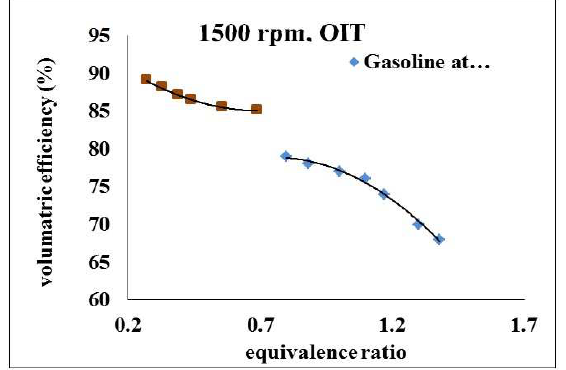
Fig. 10, brake thermal efficiency of the two systems at HUCR for each one, for wide range of equivalence ratio.